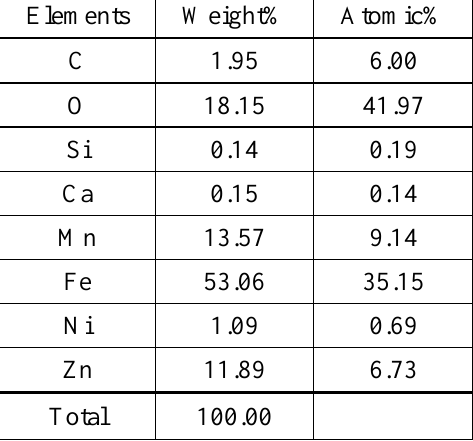
Fig.5: EDX spectrum of Ni ferrite. Table 1: Elements analysis of ferrite sample based on the EDX